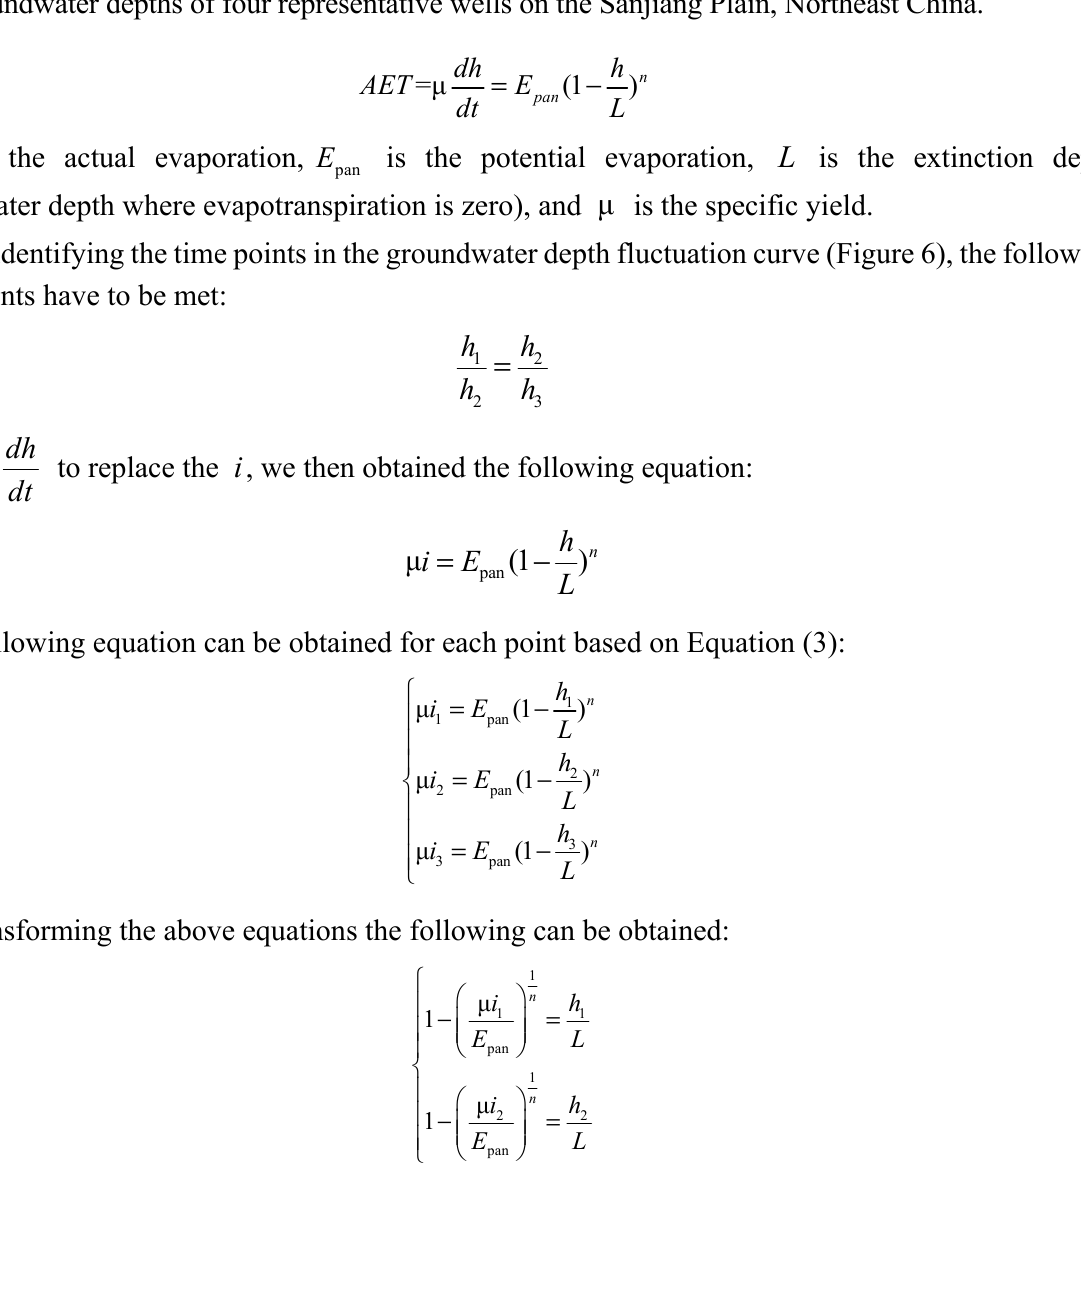
Figure 6. ( a ) Schematic diagram of a shallow groundwater depth fluctuation curve, whereby i and h are the slope and groundwater depth of each point, respectively; ( b ) Shallow groundwater depths of four representative wells on the Sanjiang Plain, Northeast